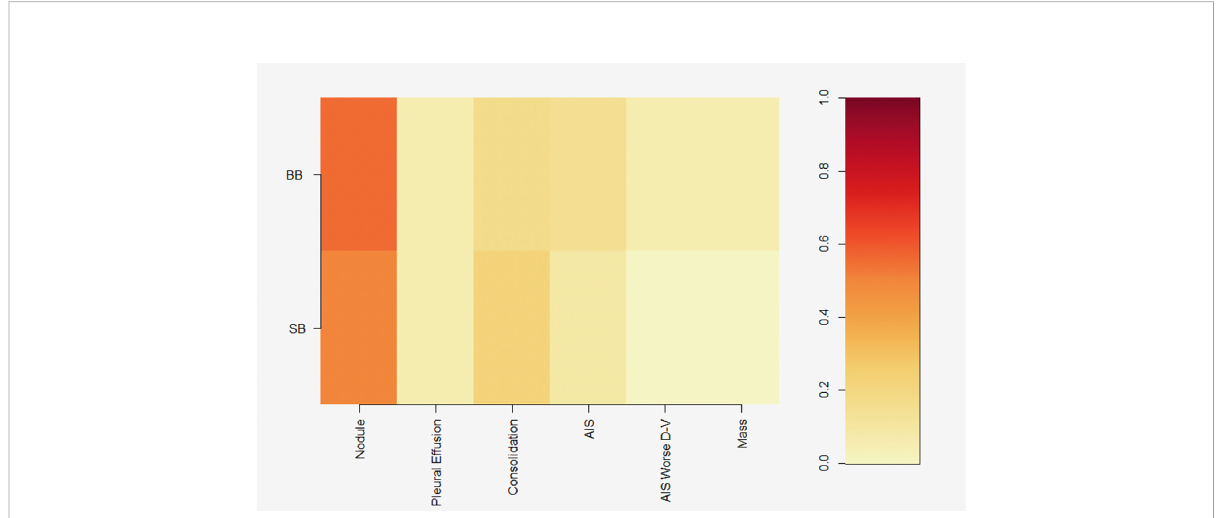
FIGURE 5 Heatmap showing prevalence of pulmonary nodules ( ‘ nodule ’ ), pleural effusion, pulmonary consolidation ( ‘ consolidation ’ ), alveolar interstitial syndrome ( ‘ AIS ’ ), AIS with increased ventral severity ( ‘ AIS Worse D-V ’ ), and pulmonary masses ( ‘ mass ’ ) diagnosed between 2011-2018 in dolphins born after the DWH spill. BB, Barataria Bay; SB, Sarasota Bay. Colors represent prevalence of conditions, as represented in color key on the